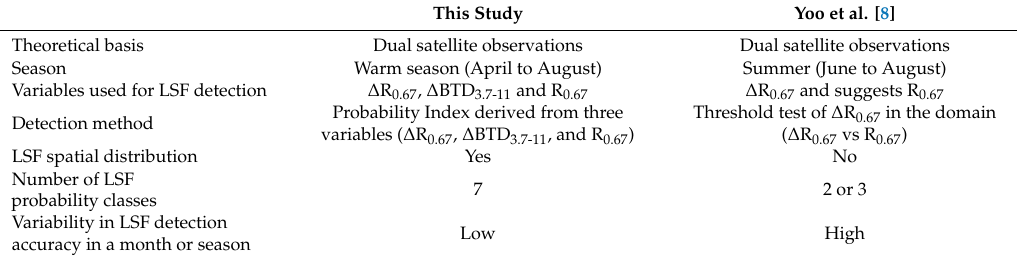
Table 6. Di ff erences in the LSF detection between this study and Yoo et al. [8]. This Study Yoo et al.